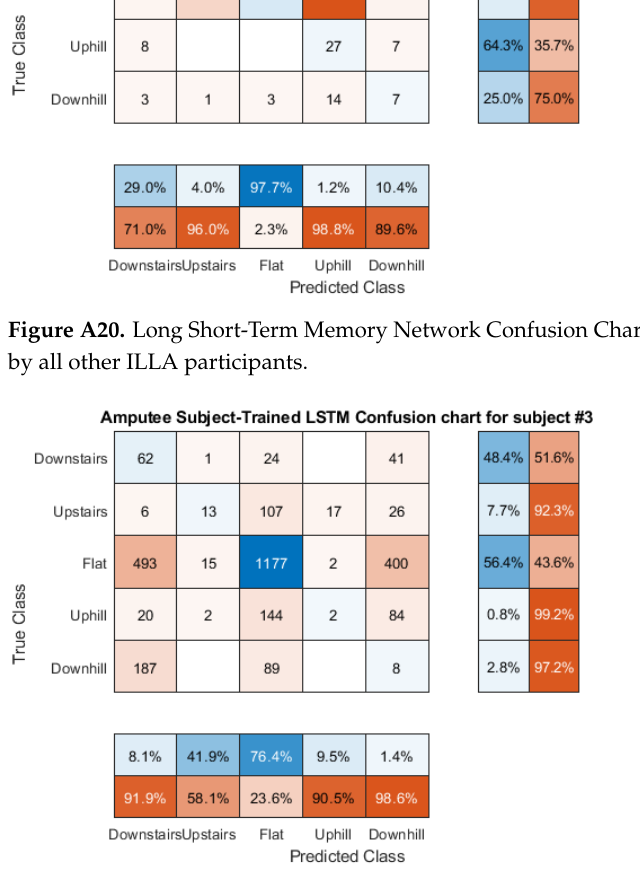
Figure A21. Long Short-Term Memory Network Confusion Chart for ILLA participant A3 as trained by all other ILLA